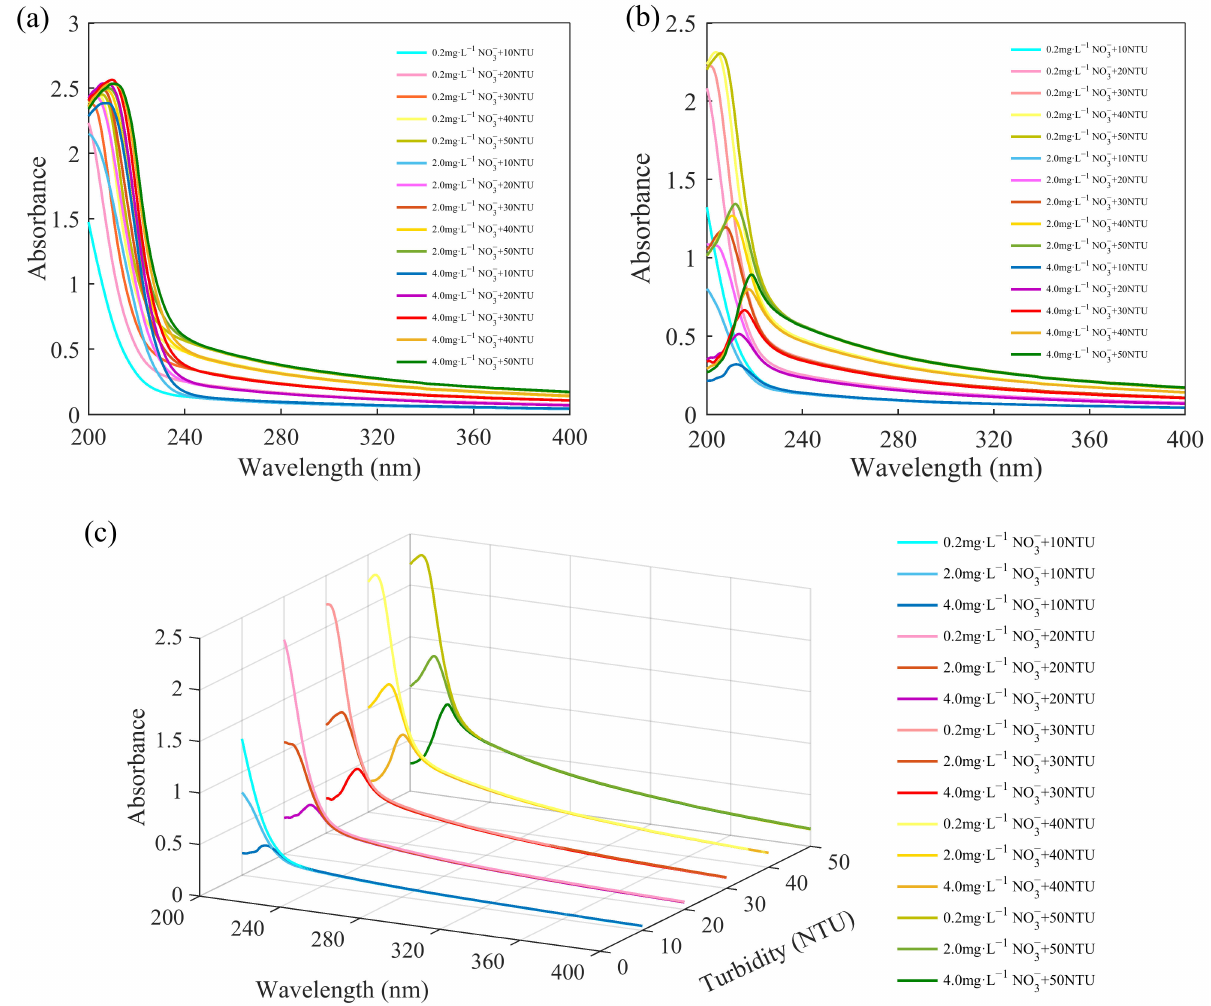
Figure 2. ( a ) Spectra of mixed solutions. ( b ) Difference spectra between the mixed solutions and standard nitrate solutions. ( c ) Difference spectra in three-dimensional